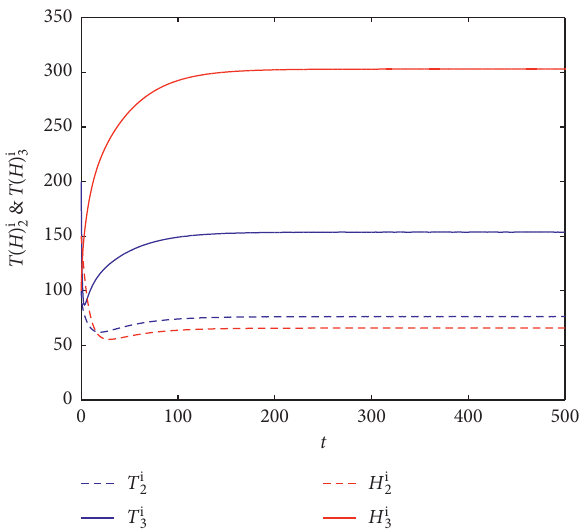
Figure 3: Solutions of model (3) reflecting the influence of the invasion of disease 2. The numbers of infectious ticks and hosts are represented by blue and red curves, respectively, where dotted lines denote the number of infected individuals with only disease 2, and solid lines denote the number of infected individuals with both diseases. It is shown that infectious individuals related to both diseases tend to � 1 . 01 > persist, and then disease 2 can invade the tick-host population as R 1 2